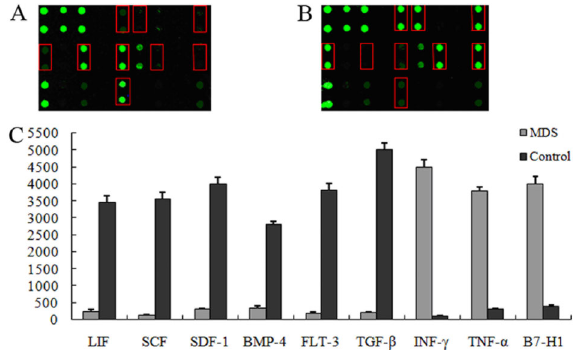
Figure 1. Expression analysis of cytokines through protein array hybridization (Student t -test). A , Signal map of myelodysplastic syndromes (MDS) group. B , Signal map of normal control group. C , Quantization of the expression level of cytokines by histogram plotting. LIF: leukemia inhibitory factor; SCF: stem cell factor; SDF-1: stromal cell-derived factor; BMP-4: bone morphogenetic protein 4; FLT-3: HSC-stimulating factor; TGF- b : transforming growth factor- b ; IFN- c : interferon- c ; TNF- a : tumor necrosis factor- a ; B7-H1: programmed death